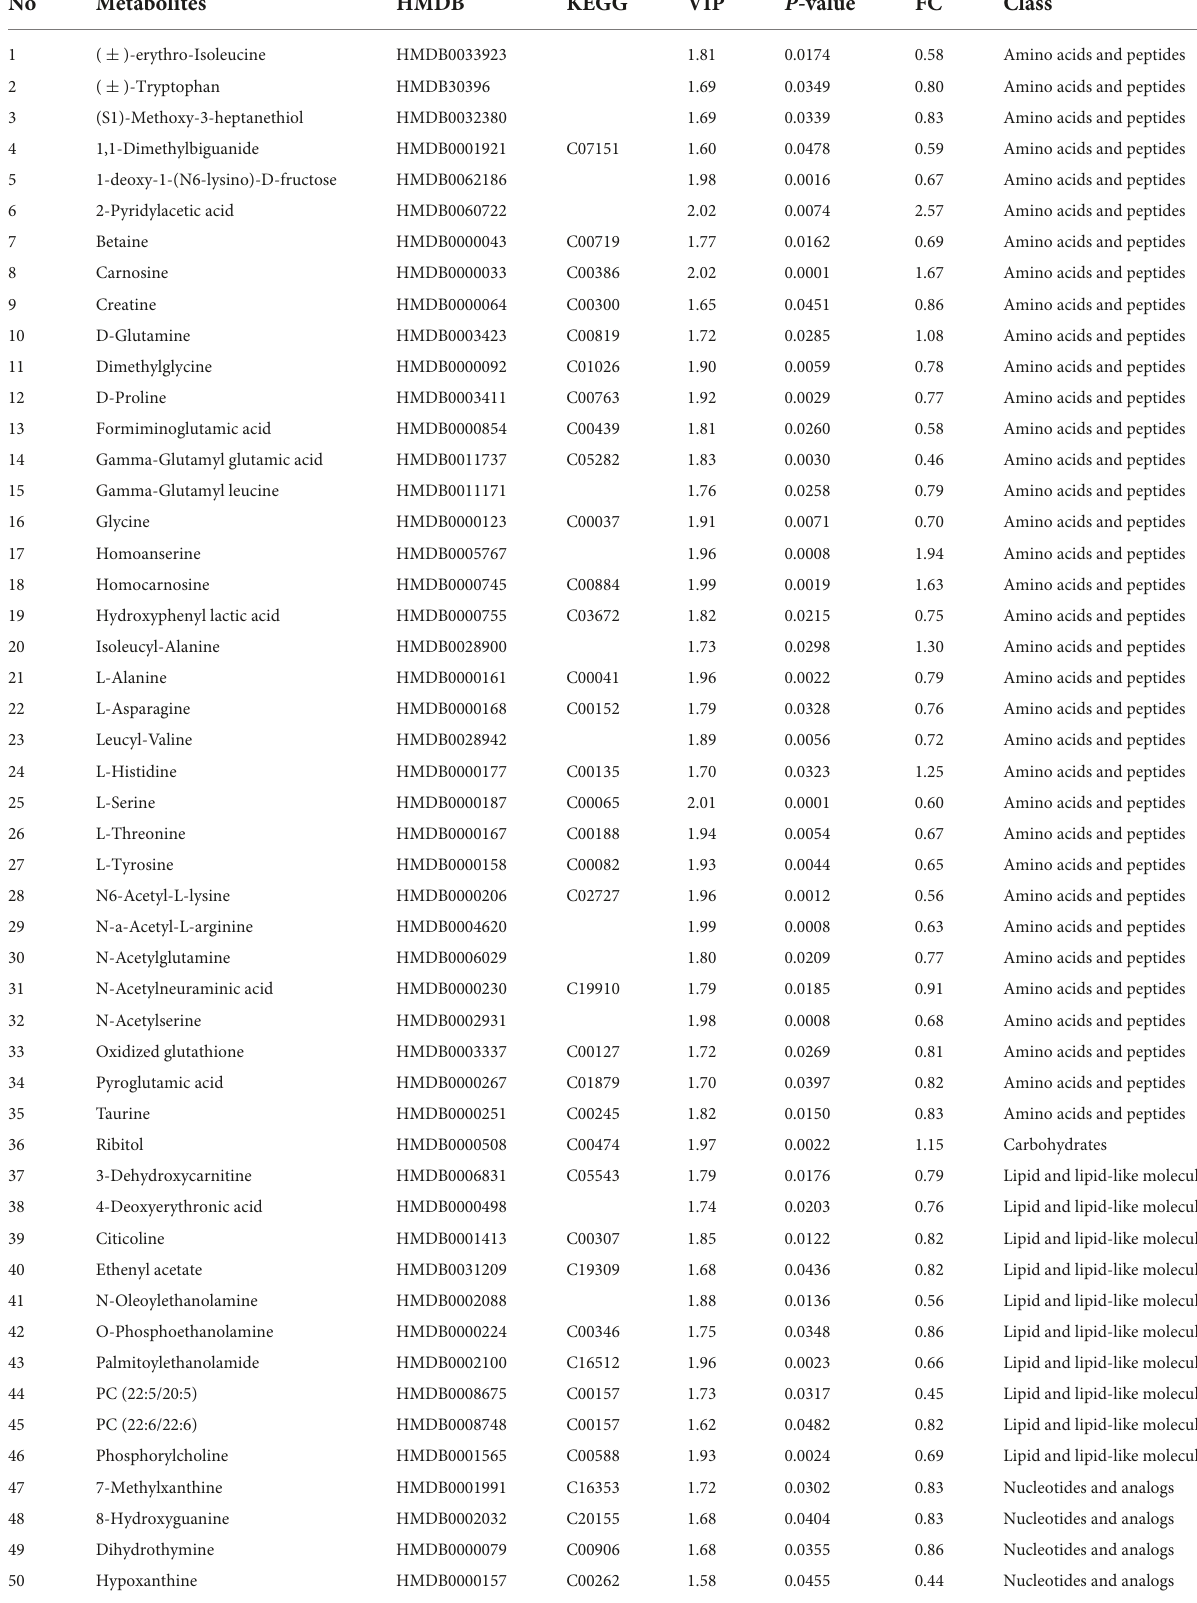
TABLE 1 The altered differential metabolites in the aged